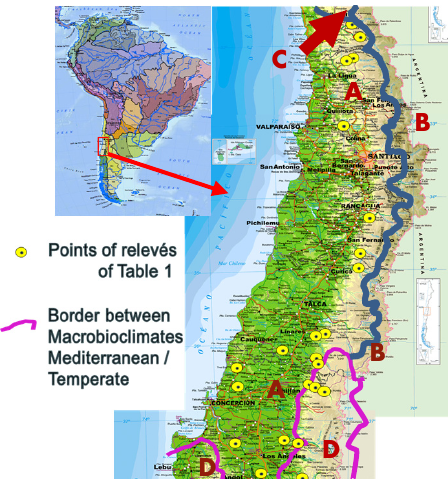
Figure 1. Administrative map of Central Chilean territory showing geographical dispersion of river points where samples gathered in Table 1 were taken. The thick lines delimit the biogeographical provinces according to Rivas-Martínez et al . (2011b): A) Central Chilean.